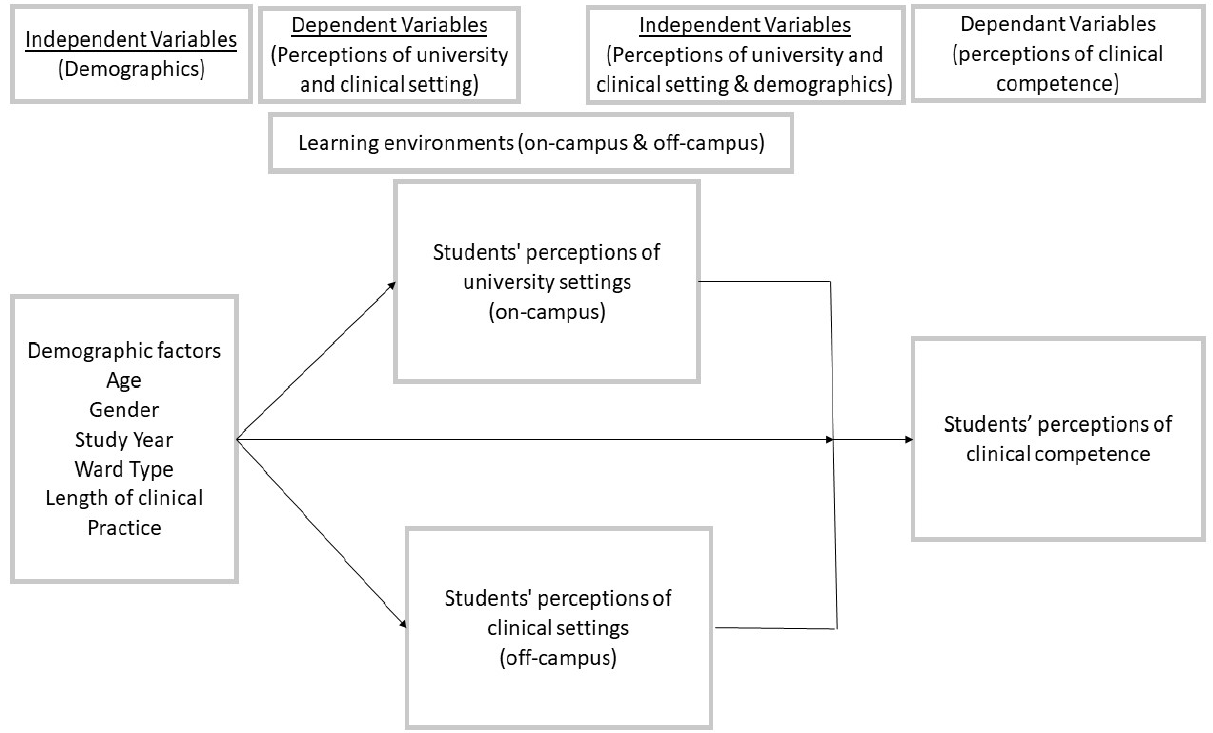
Figure 1. Conceptual model of factors affecting learning environments of nursing